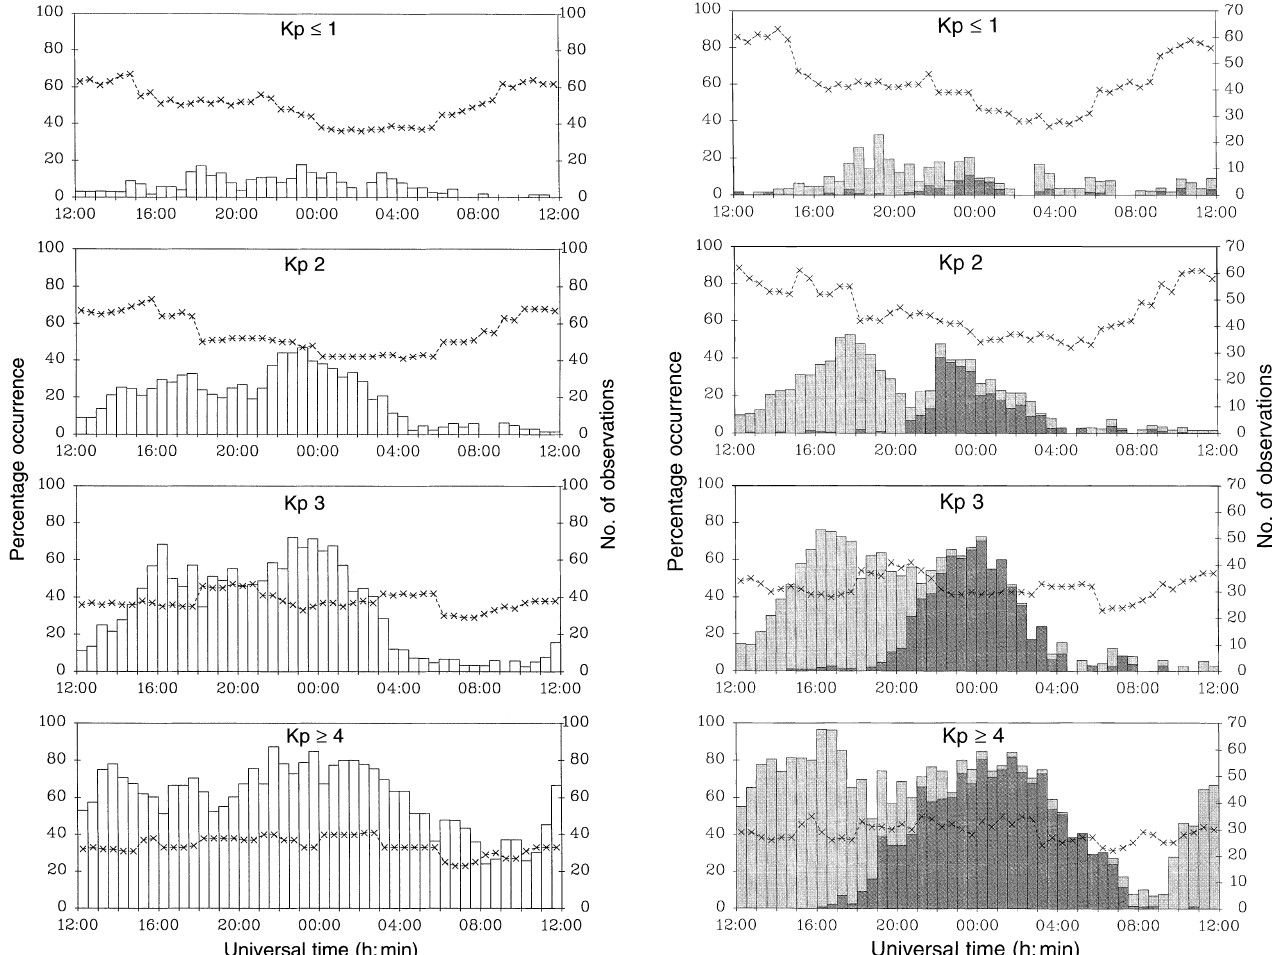
Fig. 9. Variation of the diurnal distribution of enhanced ion velocity with the level of geomagnetic activity, the latter of which is categorised according to K . Each panel is presented in the same p form as